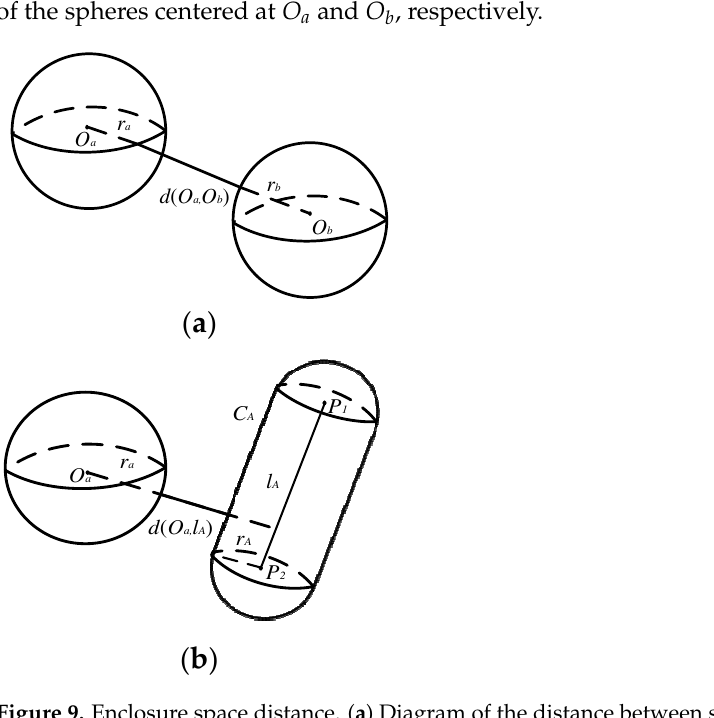
Figure 9. Enclosure space distance. ( a ) Diagram of the distance between spheres. ( b ) Diagram of the distance between spheres and